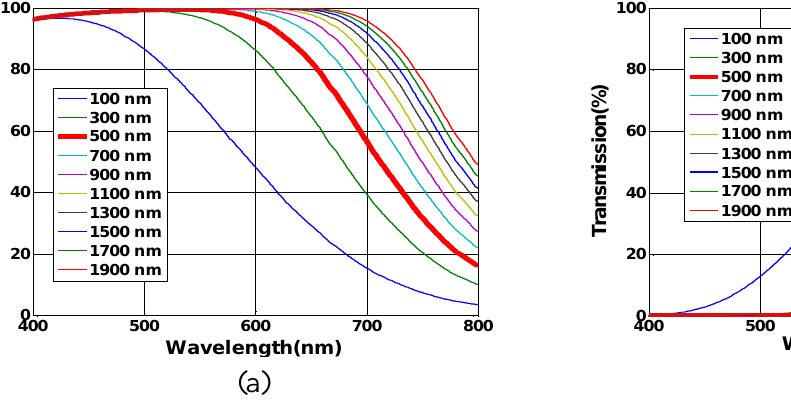
(b) Transmission characteristics of the structures. In both (a) and (b), the curve for the 500 nm thick structure is